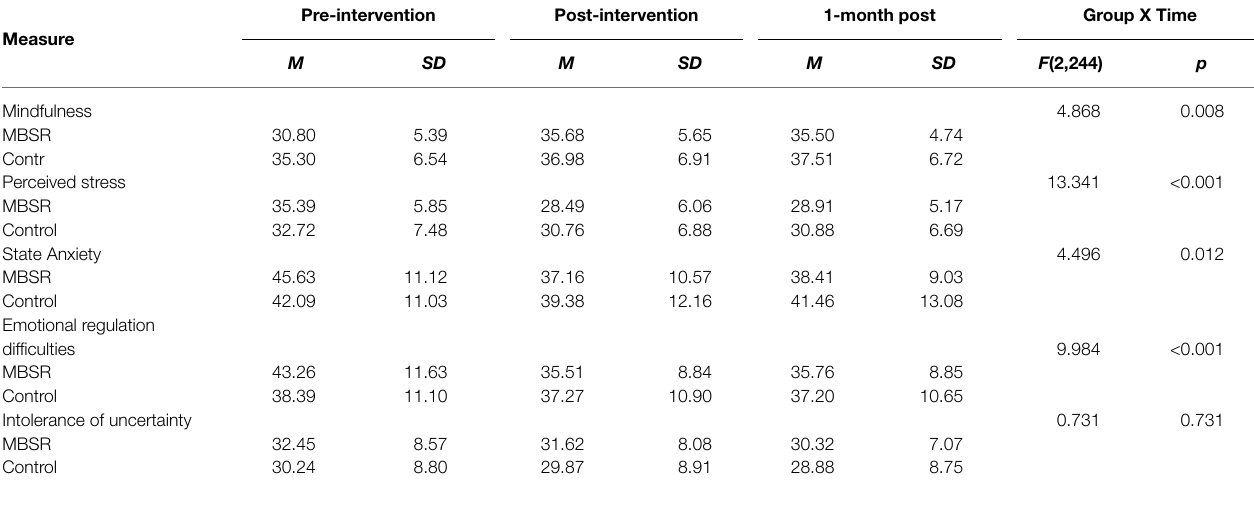
TABLE 3 | Means, standard deviations, and one-way analyses of variance interaction effects of online-MBSR.